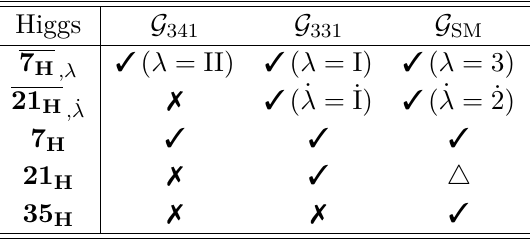
Table 7 . The Higgs fields and their symmetry breaking directions in the SU(7) model. The 3 and 7 represent possible and impossible symmetry breaking directions for a given Higgs field. The 4 represents the symmetry breaking direction that is mathematically possible, while can bring potential phenomenological constraints. The flavor indices for the Higgs fields that develop VEVs at different stages are also specified in the